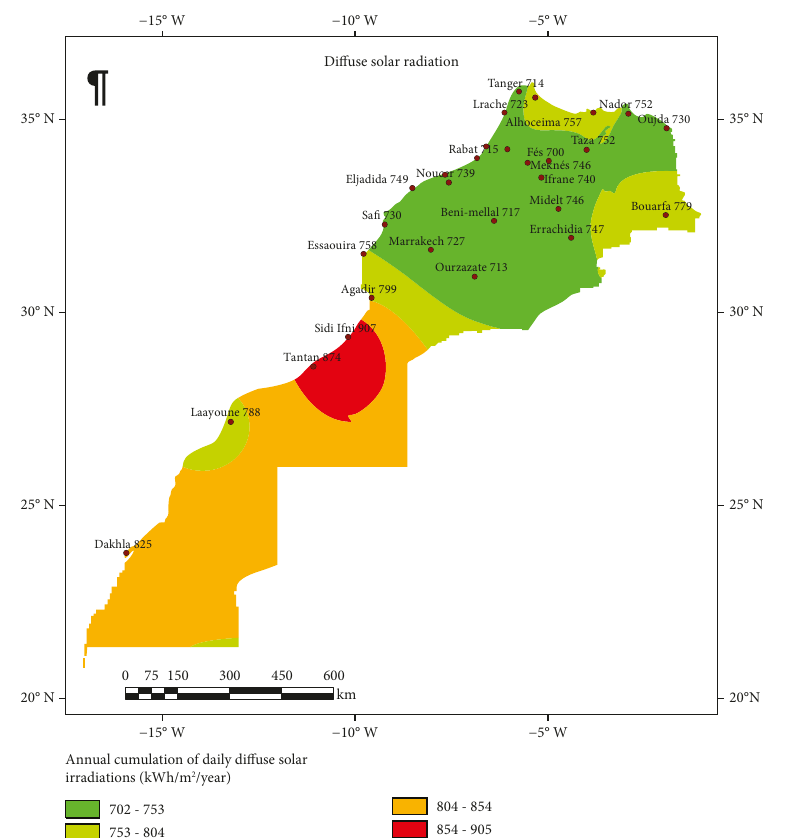
Figure 8: Map of annual cumulation of daily di ff use irradiations on a horizontal plane incident in the Moroccan territory. Map of di ff use solar radiation on a horizontal